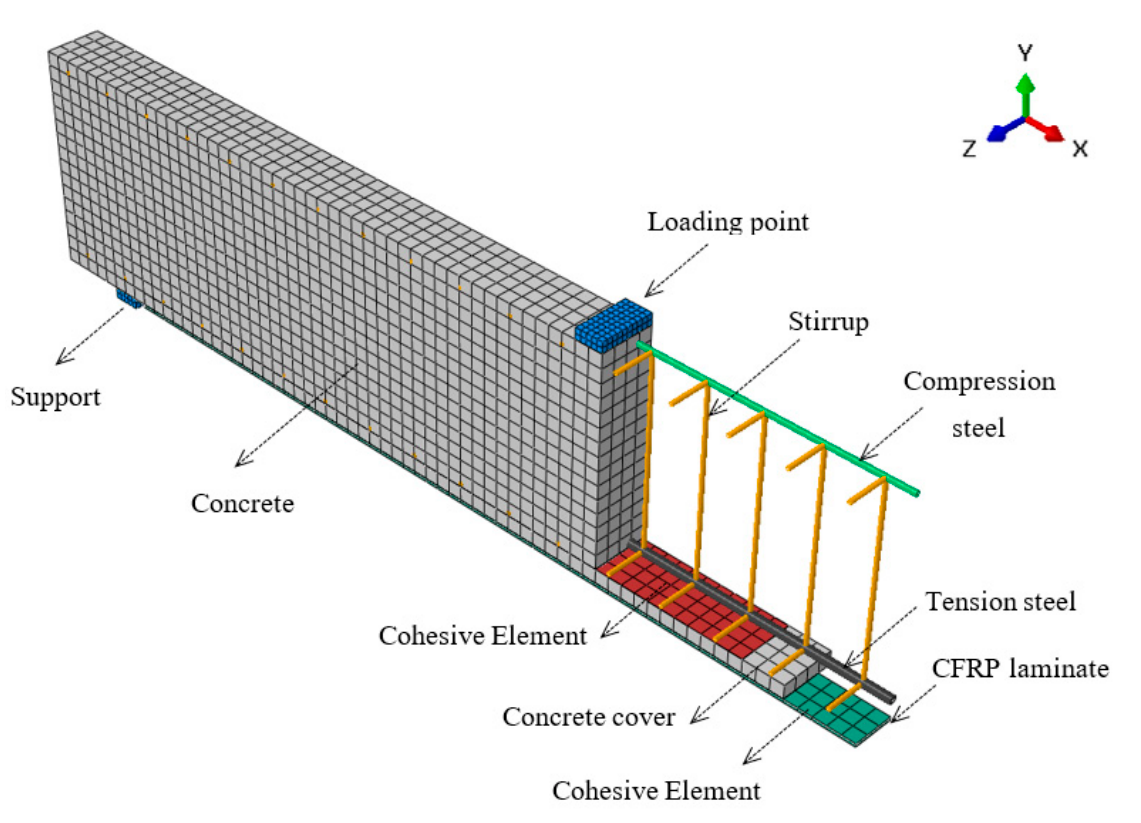
Figure 6. Geometry and elements used in the FE simulation.